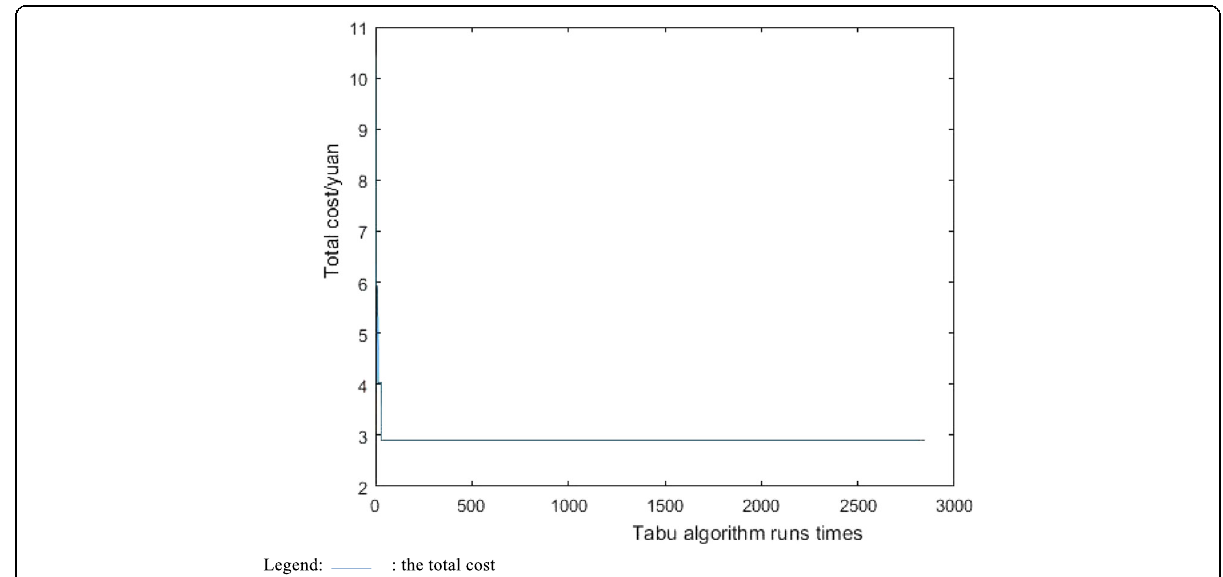
Fig. 6 When the tabu search algorithm was secondly used. Route 2 total cost variation. The blue line represents the total